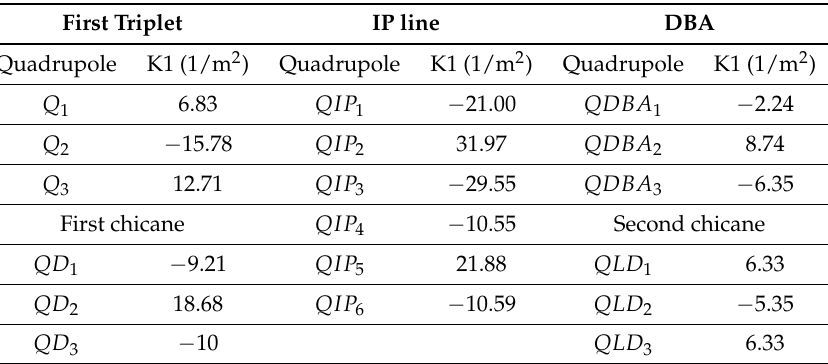
Figure 7. Transverse dispersions (top left box), normalized emittances (top right box), beta functions (bottom left box), and transverse sizes (bottom right box) as a function of the distance s along the beam line from the Linac exit. Table 3. Quadrupole parameters